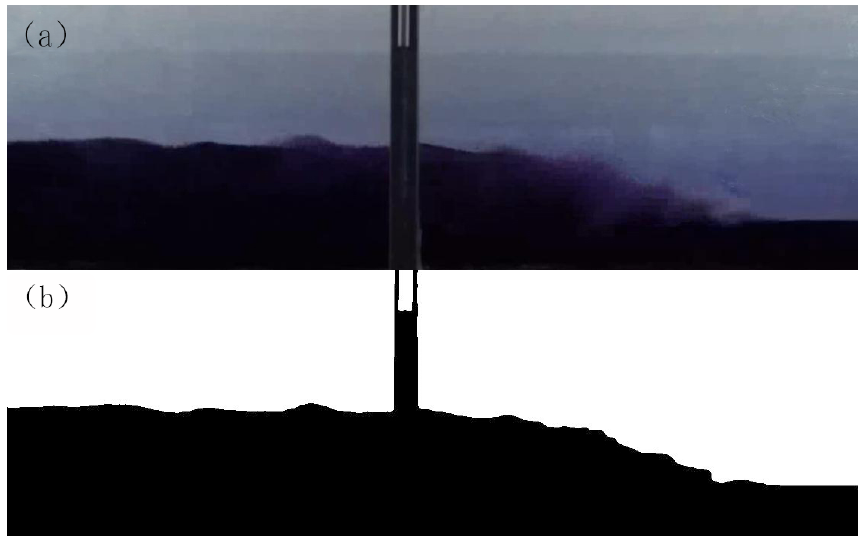
Figure 3. Picture binarization. ( a ) original image; ( b ) binarized image.